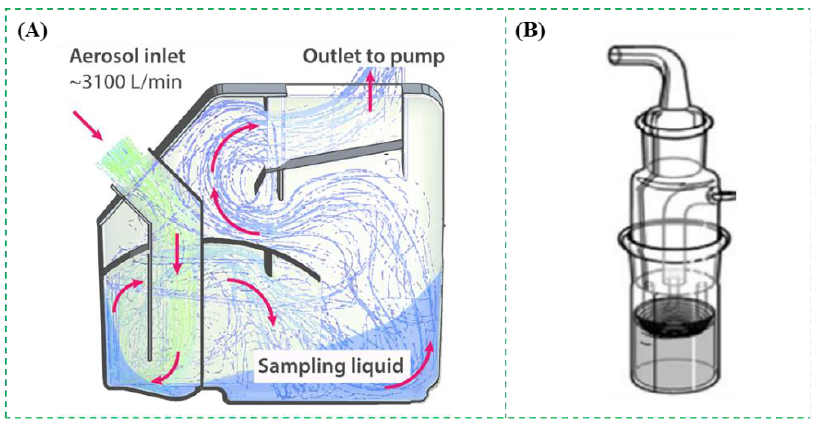
Figure 5. ( A ) The impinger for collection of the bioaerosols. Reprinted with permission from ref. [56]. Copyright 2017 American Chemical Society. ( B ) The liquid impinger BioSampler for collection of bioaerosol particles [57]. Reprinted with permission from ref. [57]. Copyright 2017 Elsevier B.V.